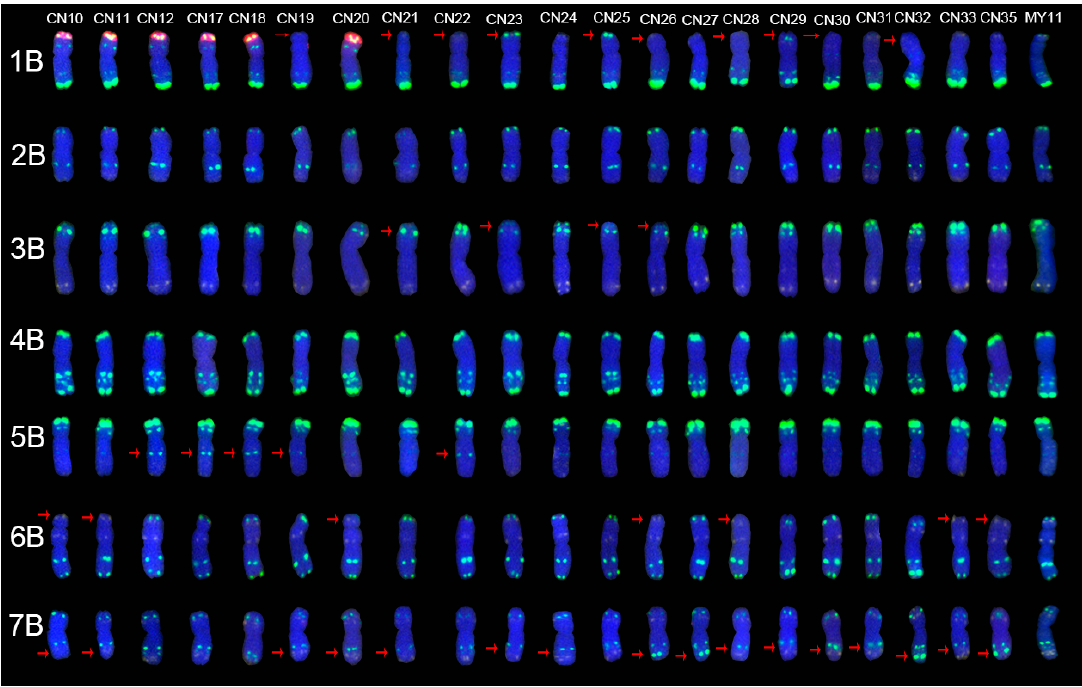
Figure 2. The ND-FISH results of B-genome chromosomes of all materials. From left to right: CN10, CN11, CN12, CN17, CN18, CN19, CN20, CN21, CN22, CN23, CN24, CN25, CN26, CN27, CN28, CN29, CN30, CN31, CN32, CN33 and CN35, respectively. From top to bottom: 1B, 2B, 3B, 4B, 5B, 6B and 7B chromosome, respectively. The red arrows showed the mutant signal patterns on chromosomes. Yellow: Oligo-pTa535-1; Green: Oligo-pSc119.2-1; Red: Oligo-Ku, Oligo-pSc200 and Oligo-pSc250.Blue: DAPI.